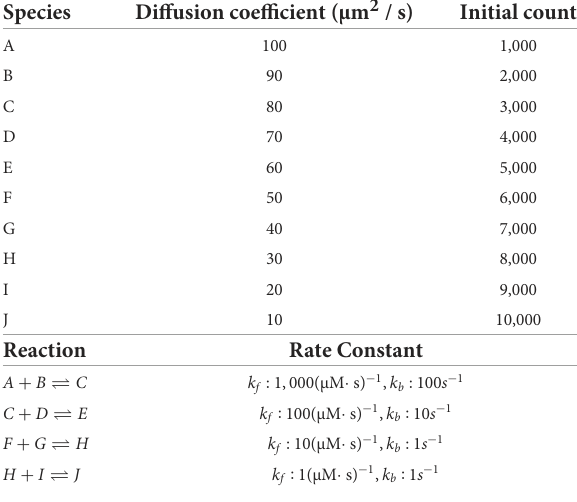
TABLE 3 Species and reactions as well as the initial configuration of the simple model. Species Diffusion coefficient (µm 2 /